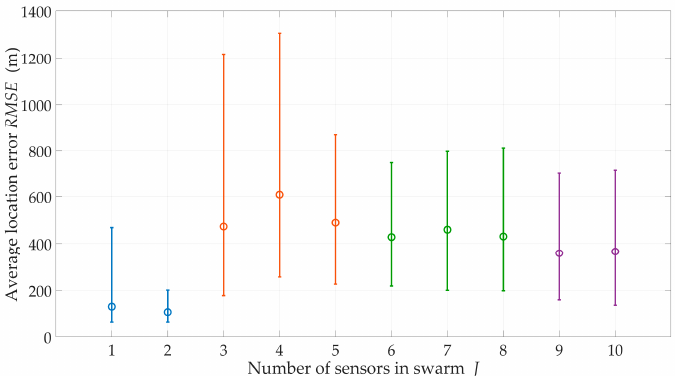
Figure 7. Average location error versus the number of sensors in the swarm for a suburban area.